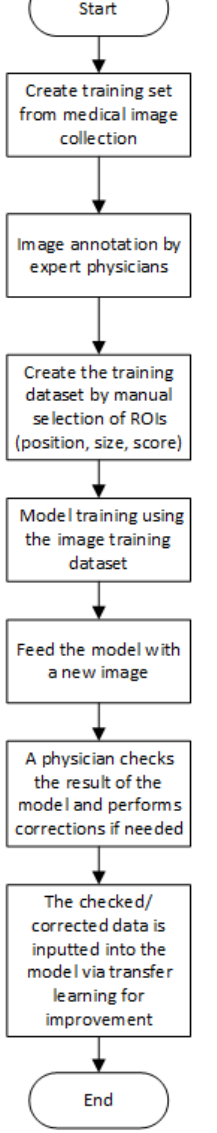
Figure 4. Block diagram for work of [10].